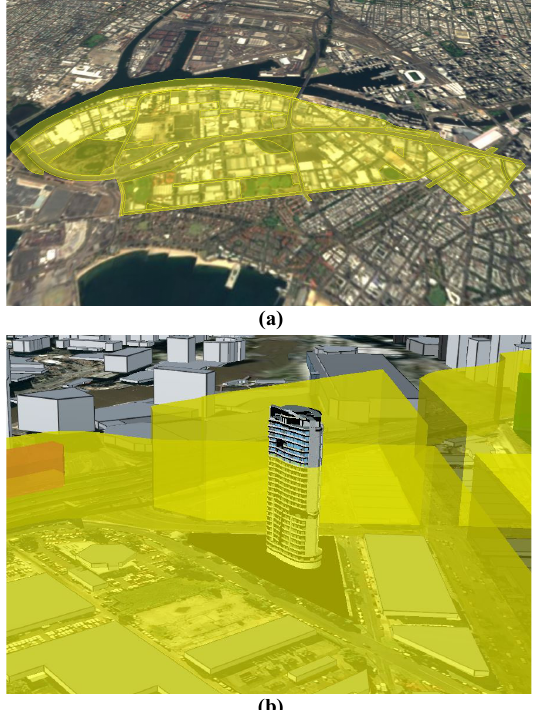
Figure 5 . a) Part of zoning map in Fishermans Bend precinct; b) Building height regulation in 3D using extrusion  Energy efficiency protection and overshadowing open space: Although the application of energy efficiency protection and overshadowing open space regulations is different, their modelling process is quite similar. Currently, proposed building’s shadow on the terrain and considering the sun’s position (altitude: α; azimuth: z) at the specified